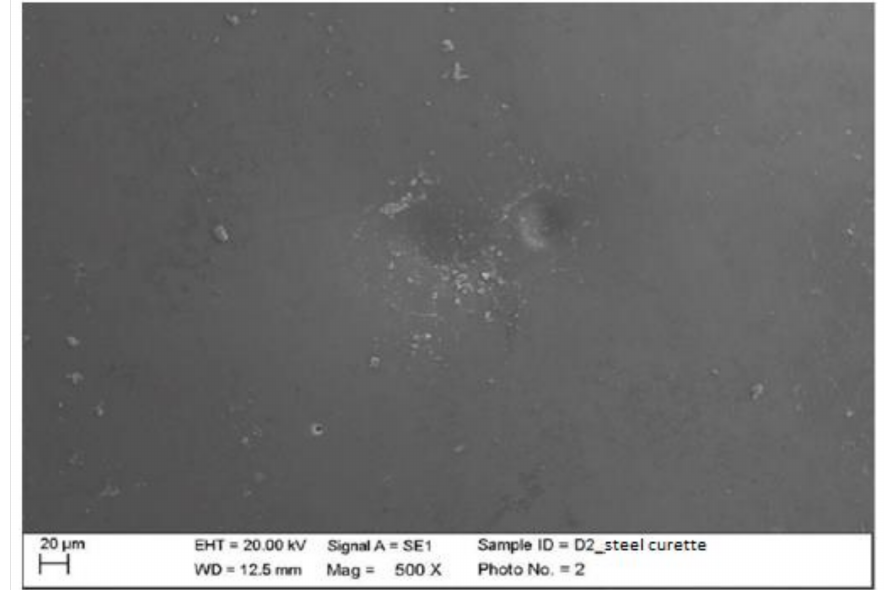
Figure 12. Instrumented disilicate sample D2 with steel curette (500 ×